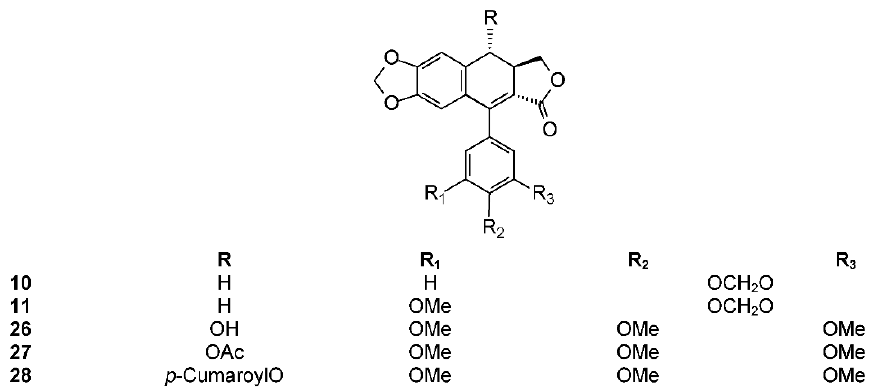
Figure 4. 7 (cid:48) ,8 (cid:48) -Dehydro-aryltetraline lignans isolated from Bursera Figure 4. 7 ′ ,8 ′‐ Dehydro ‐ aryltetraline lignans isolated from Bursera spp.